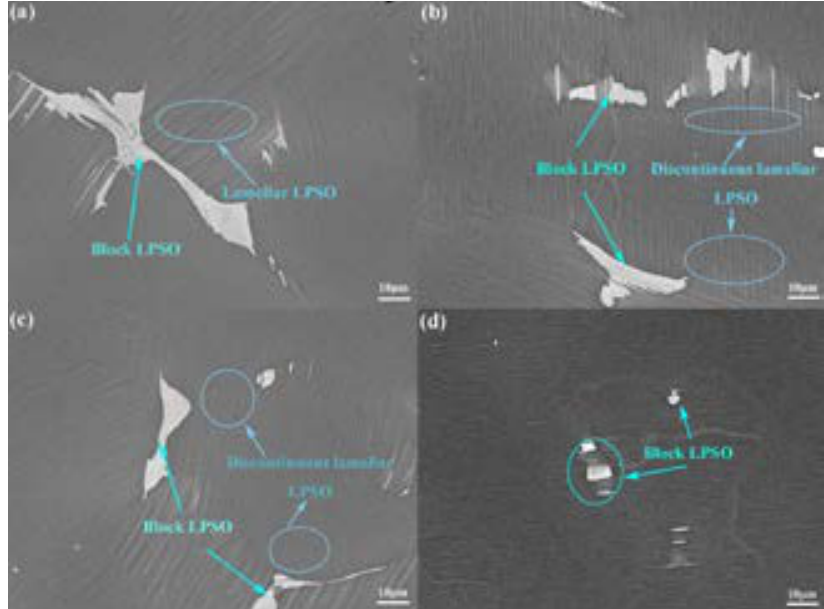
Figure 3. Typical SEM images of Mg-Zn-Y magnesium alloys with different content of Zr: (a) A alloy; (b) B alloy; (c) C alloy; (d) D